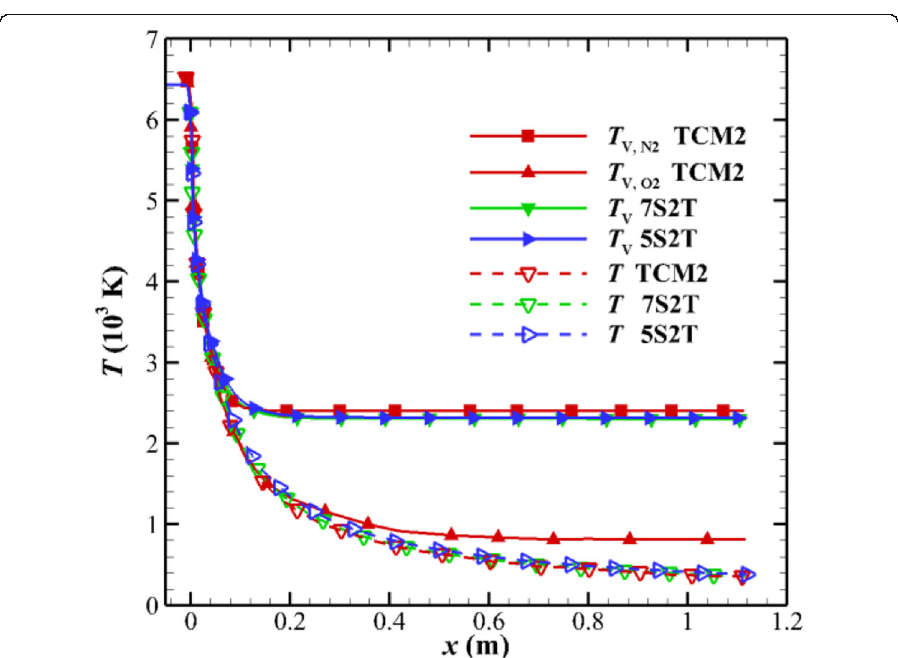
Fig. 2 Comparison of the centerline temperature distributions